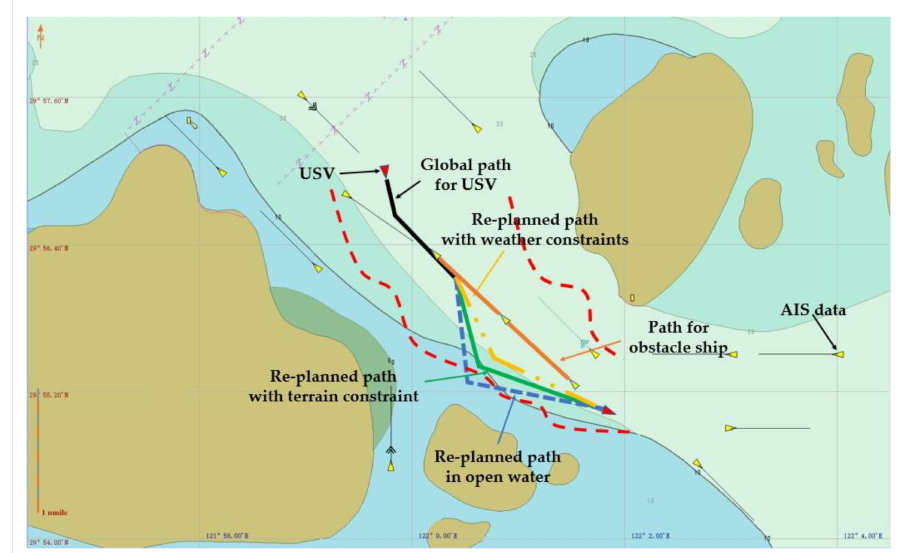
Figure 17. HIL test results for for a representative head-on encounter in restricted water.